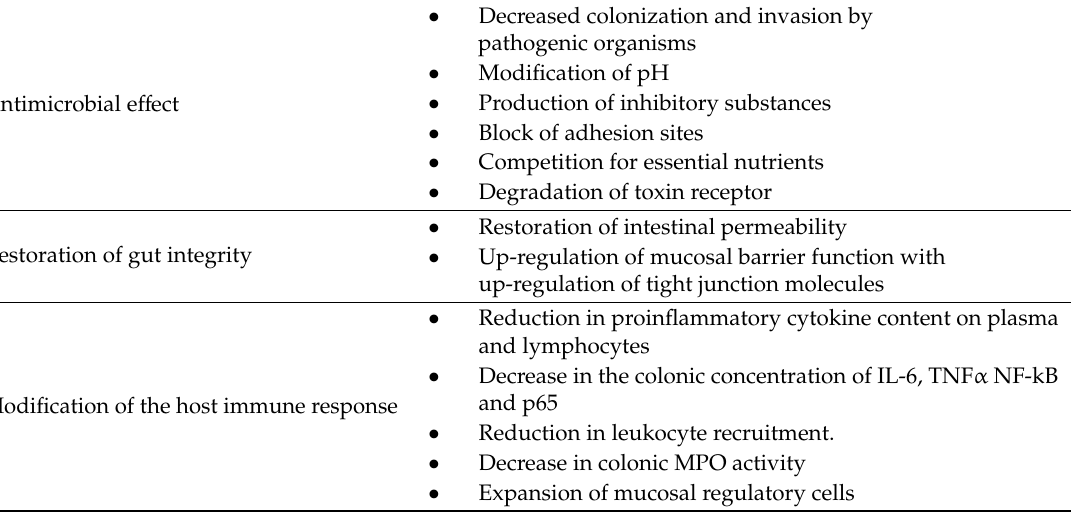
Table 3. Main mechanisms of action of probiotics (modified from Triantafillidis et al. [68]).